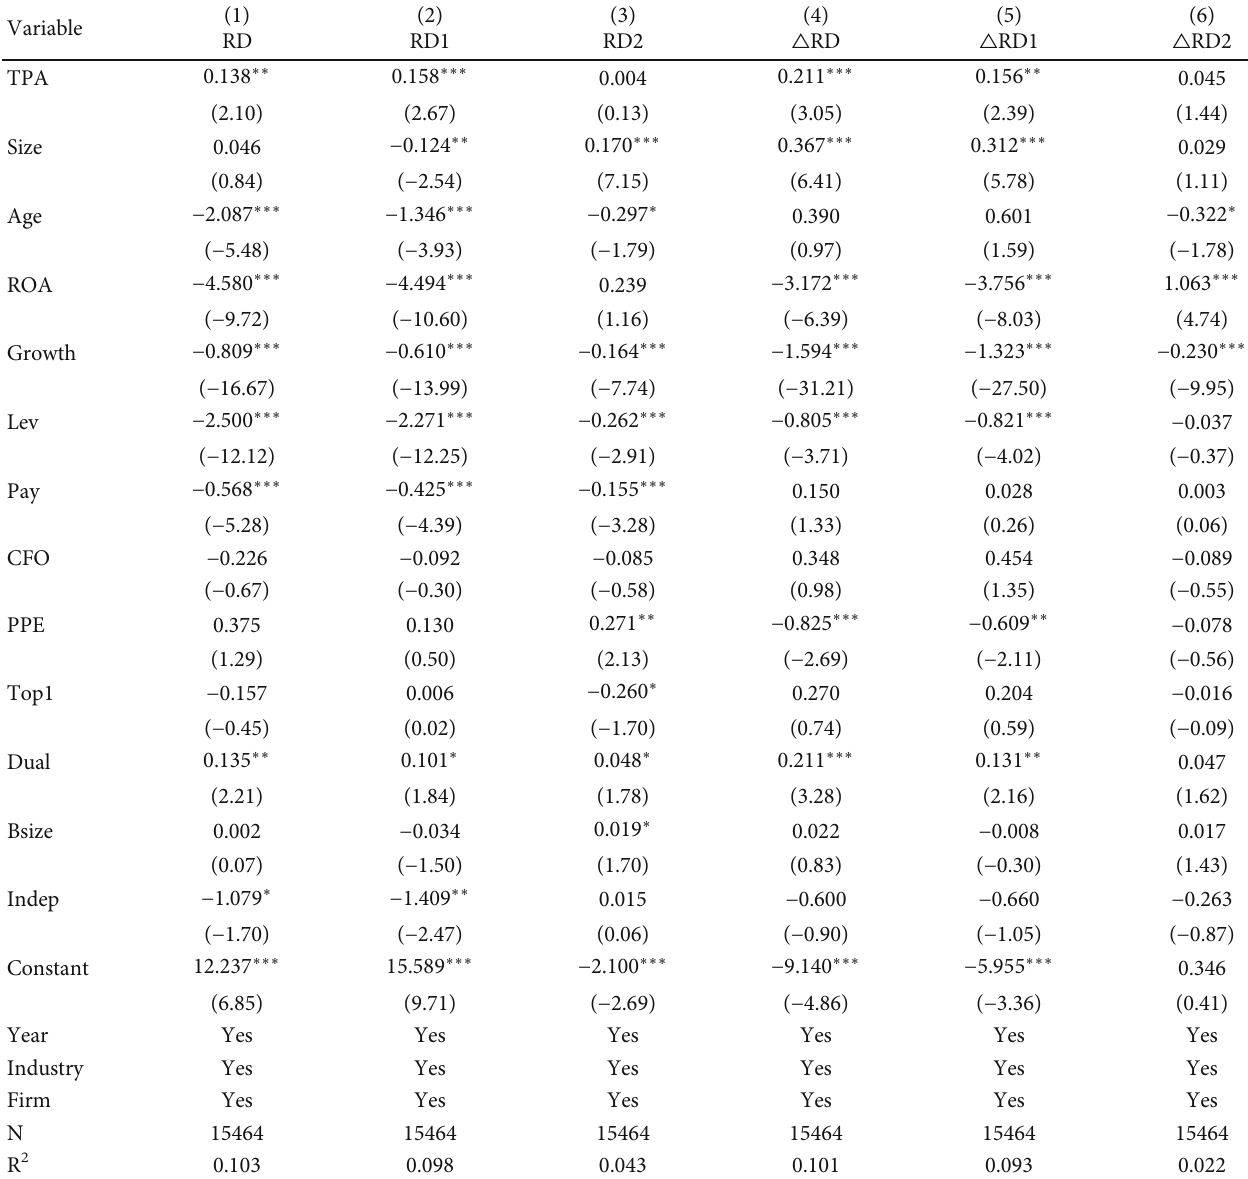
Table 4: Participation in targeted poverty alleviation and company innovation